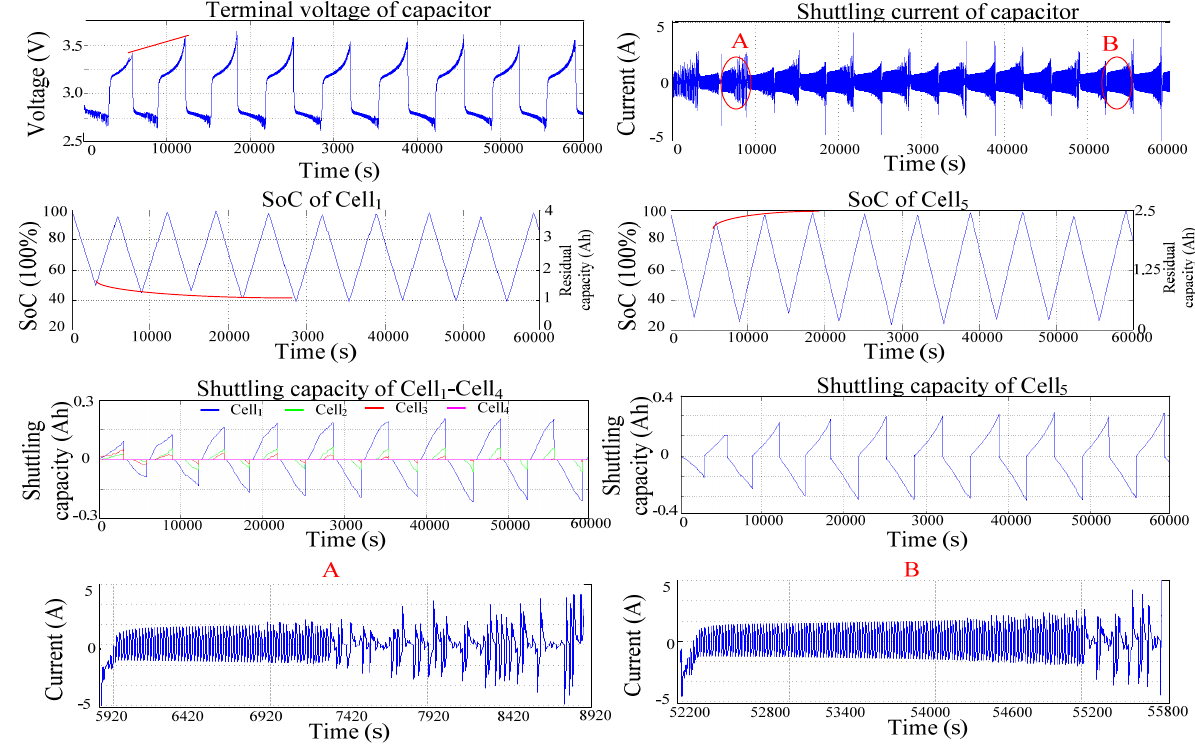
Figure 8. DSM-based balance (without terminal voltage